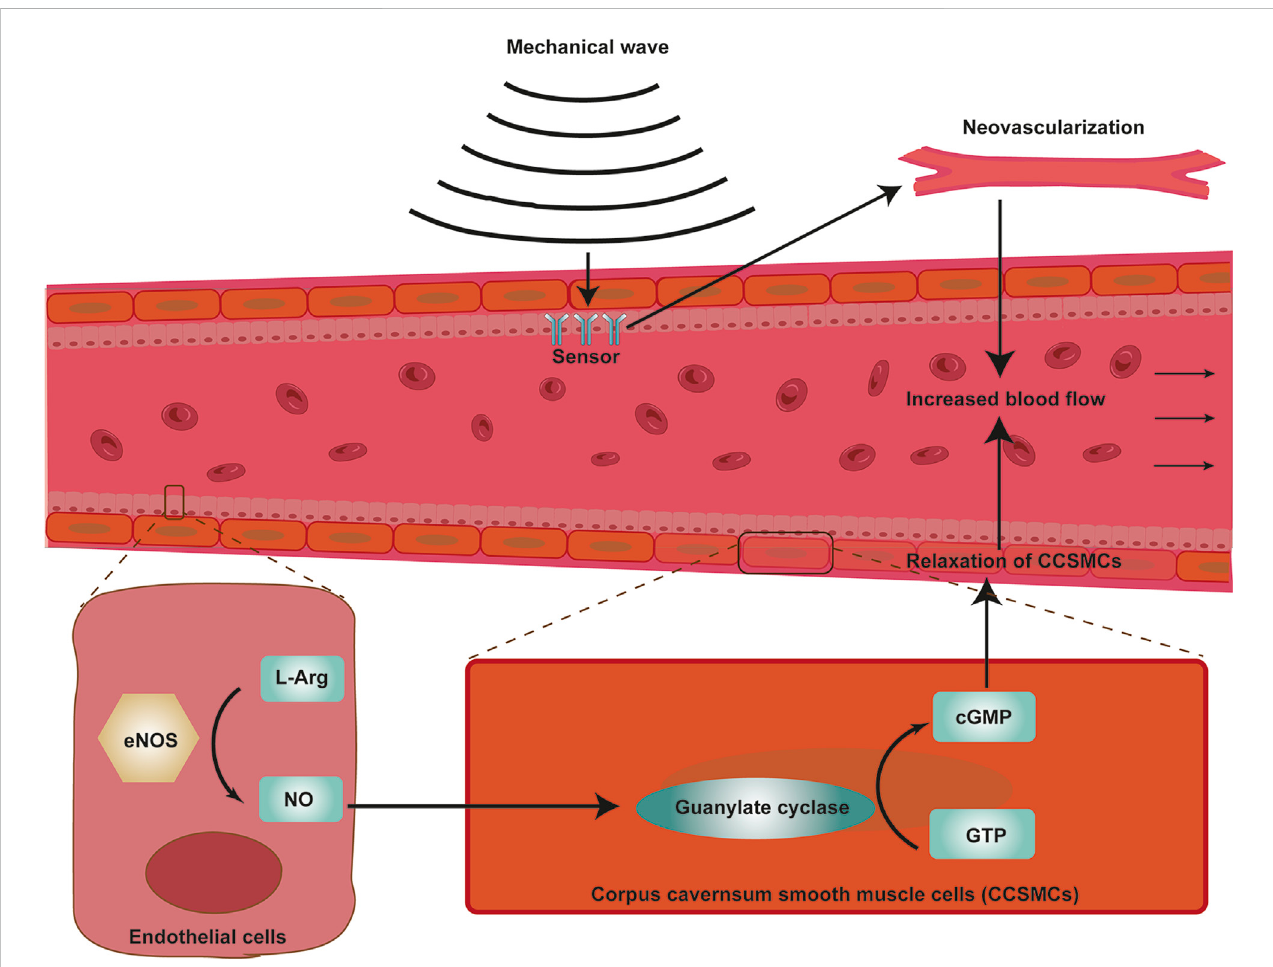
FIGURE 3 Mechanism of Li-ESWT for the treatment of ED. Mechanical waves stimulate the endothelial mechanosensors of the blood vessels, resulting in neovascularization. It also stimulates nNOS production in vascular endothelial cells, smooth muscle cells, and nerve cells, and cGMP production increases. Together, these promote increased blood fl ow to the penile corpus cavernosum and penile